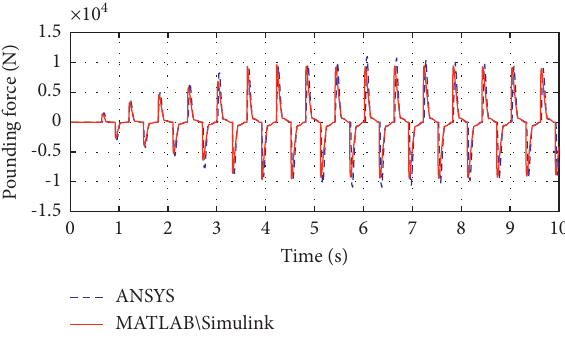
Figure 6: : Pounding force of the single DOF structure controlled by Table 3: : Vibration control performance of the PTMD.